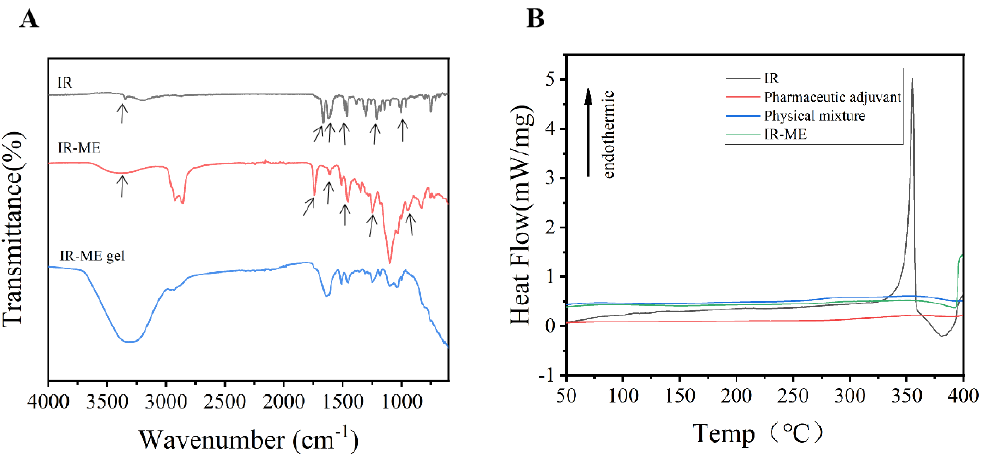
Figure 3. Drug and adjuvants compatibility. ( A ) FTIR spectra of IR, IR-ME, and IR-ME gel (arrows indicate the characteristic infrared absorption peak of IR). ( B ) DSC thermograms of IR, Pharmacevtic adjuvant, physical mixture and IR-ME.